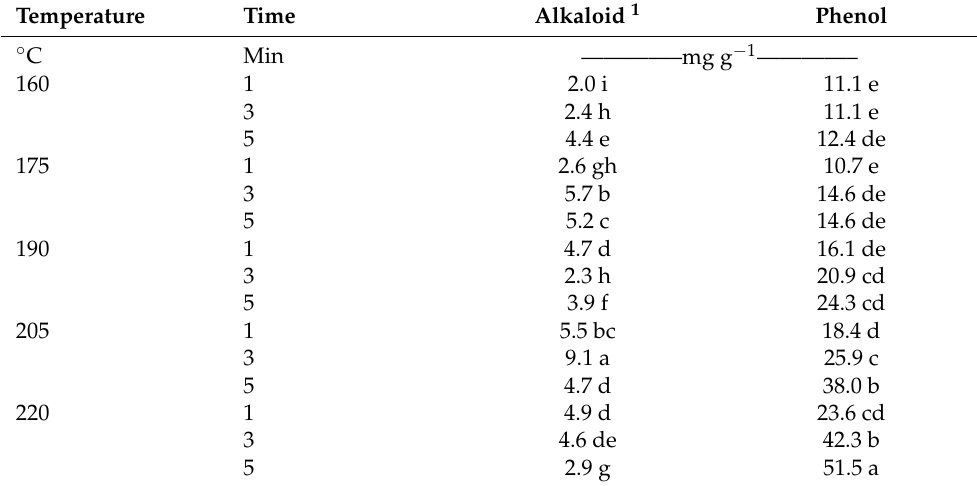
Table 3. Concentration of total phenol and total alkaloid as affected by temperature × retention time interaction.